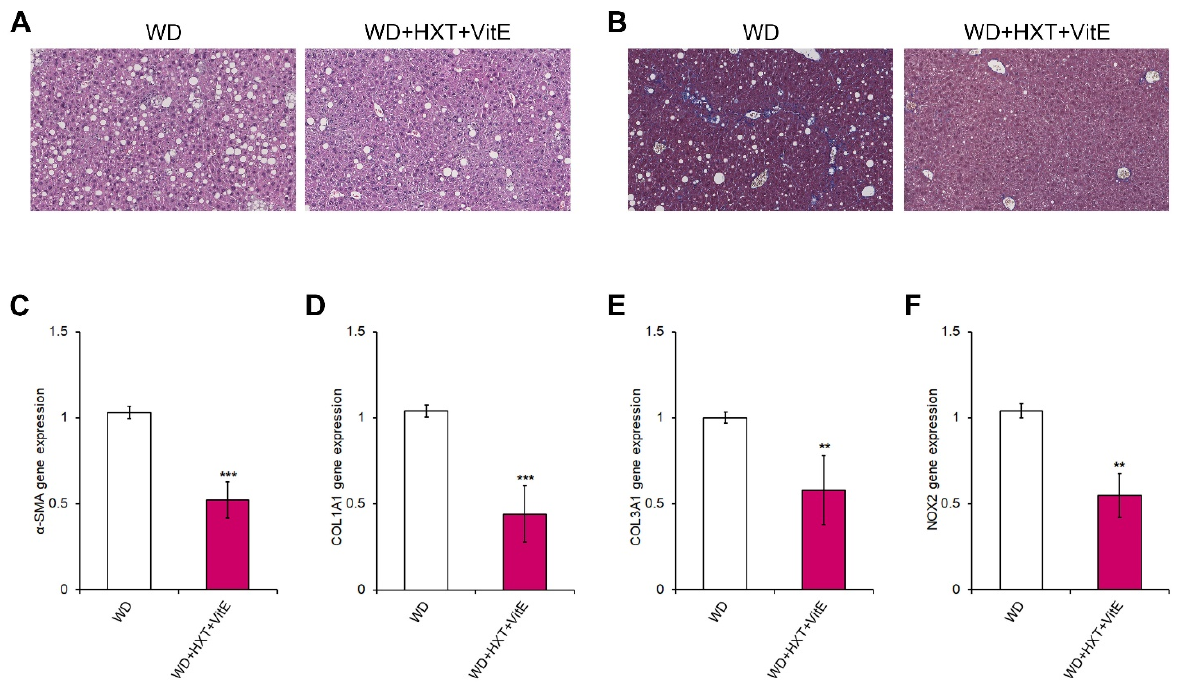
Figure 4. HXT + VitE improves WD-induced liver fibrosis in mice. Representative images of H&E ( A ) and Mason’s trichrome ( B ) staining in liver sections of WD and WD + HXT + VitE mice (20× magnification). Hepatic gene expression by qRT-PCR of α -SMA ( C ), COL1A1 ( D ), COL3A1 ( E ), and NOX2 ( F ) in WD and WD + HXT + VitE mice. Data are expressed as the mean ± SD of at least three independent experiments. ** p < 0.01 and *** p < 0.001 vs. WD.